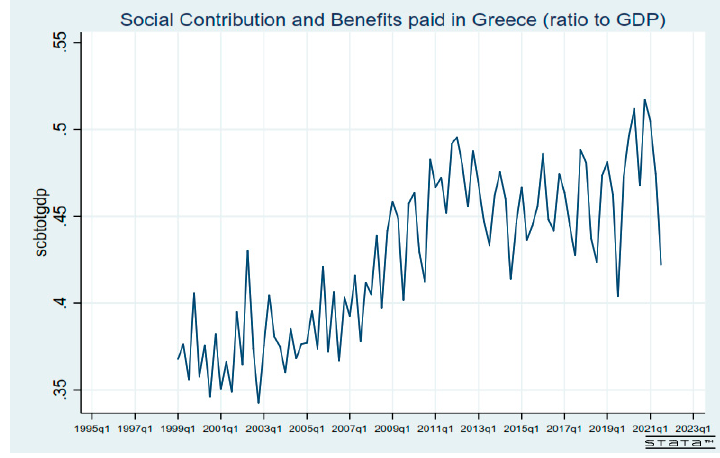
J. Risk Financial Manag. 2022 , 15 , x FOR PEER REVIEW Figure A1. Social Contribution and Benefits Paid in Greece (ratio to GDP). Figure A1. Social Contribution and Benefits Paid in Greece (ratio to GDP).